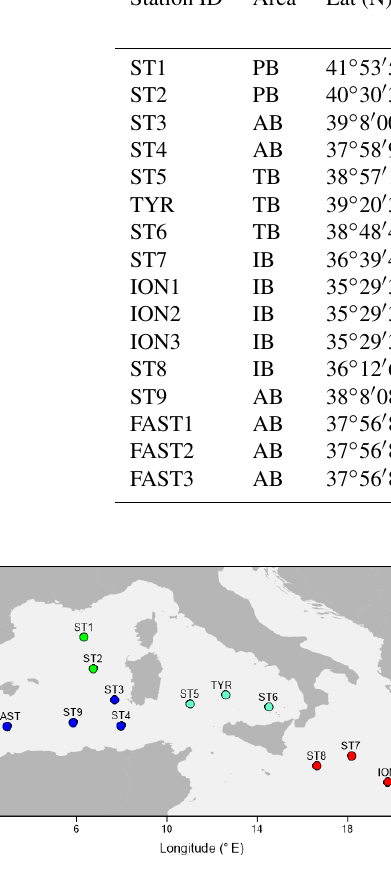
Figure 1. A map showing the sampling points during the PEACE- TIME cruise 2017. The colors of the points indicate the different areas considered over the course of the study: green dots denote the Provencal Basin (PB), dark blue dots denote the Algerian Basin (AB), light blue dots denote the Tyrrhenian Basin (TB), and red dots denote the Ionian Basin